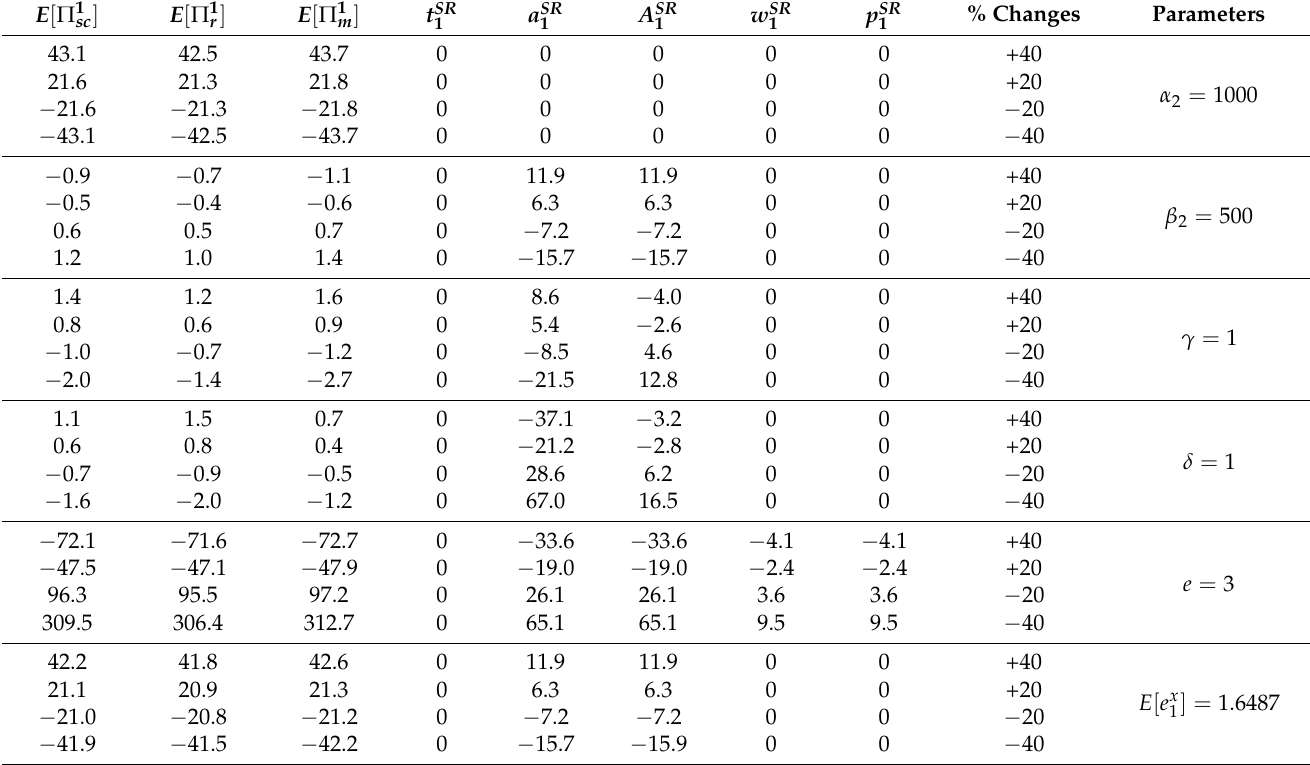
Table 9. The results of the sensitivity analysis in the SG-RL for the first